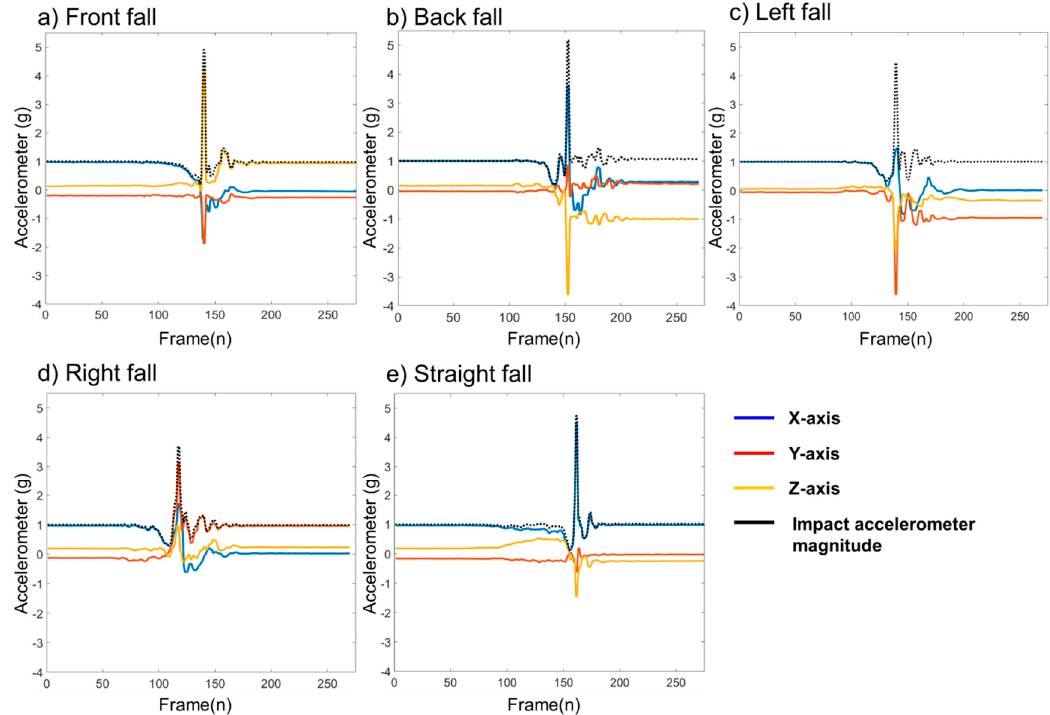
Figure 4. Tri-axial accelerometer collected from an inertial measurement unit (IMU) for five types of falls. ( a ) the IMU signal for forward fall; ( b ) the IMU signal for backward fall; ( c ) the IMU signal for leftward fall; ( d ) the IMU signal for rightward fall; ( e ) the IMU signal for straight fall.